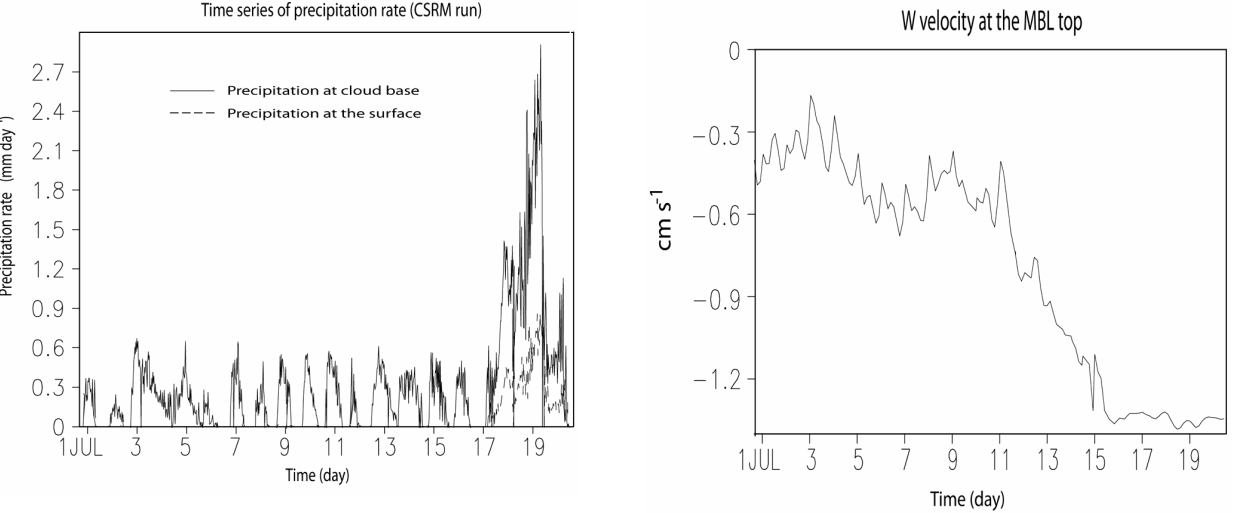
Fig. 15. Time series of area-averaged large-scale vertical velocity (w) (cms − 1 ) at the MBL top for the CSRM run.